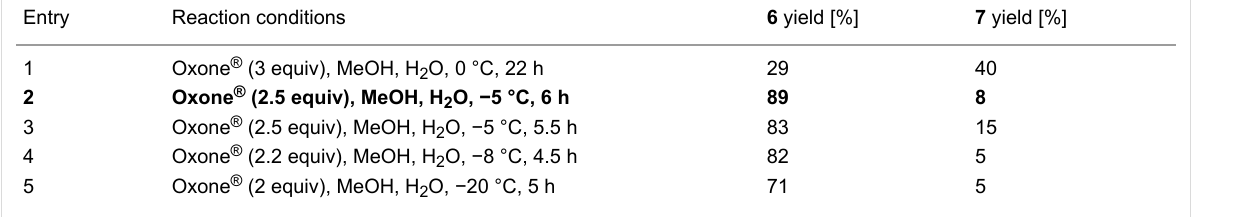
Table 1: Different reaction conditions used to improve the yield of the sulfone 6